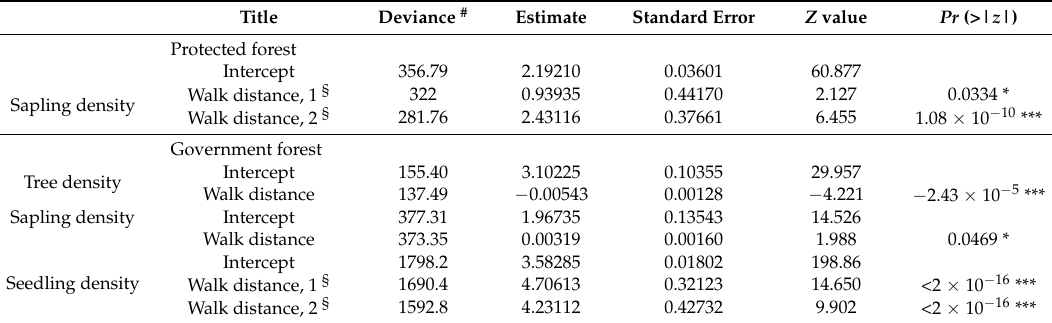
Table 5. Generalized Linear Model (GLM) summary statistics of regeneration density and walking distance (walking distance refers to the walking time in minutes from nearest settlement to the forest plots).